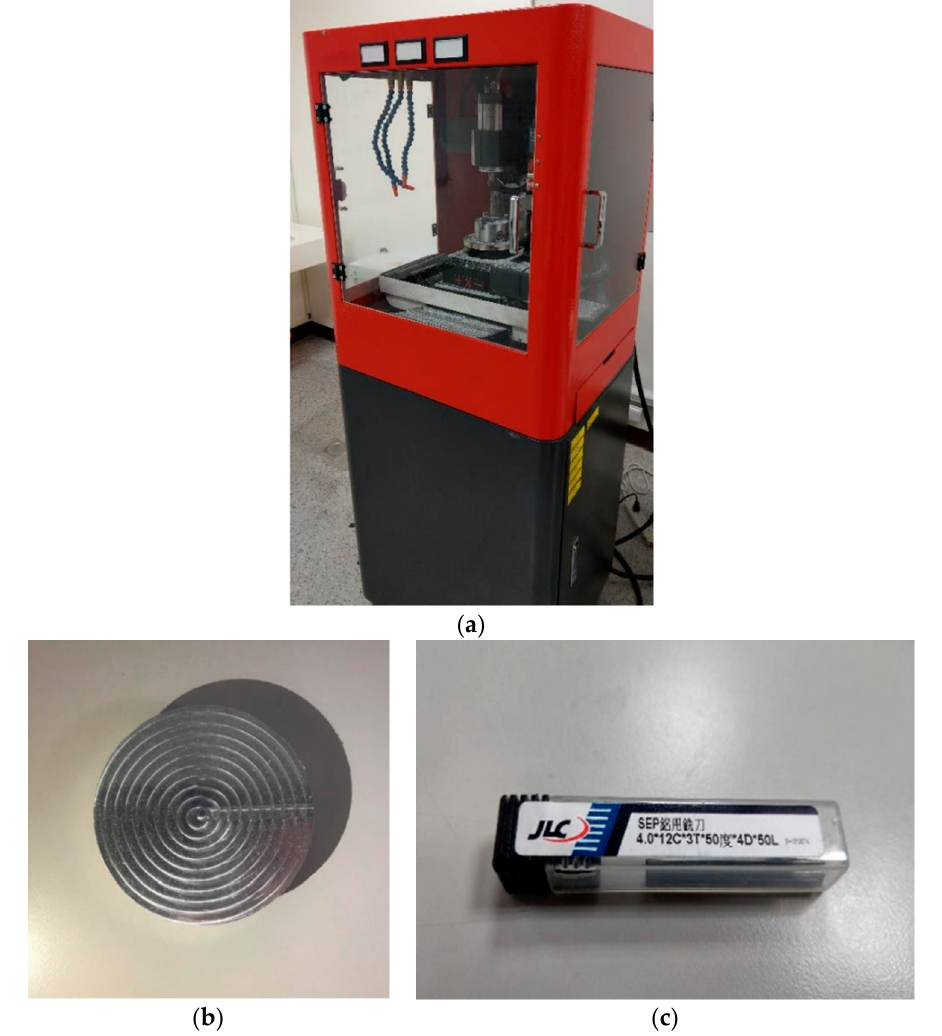
Figure 3. Machine tools and equipment. ( a ) Mini 5-Axis-CNC small five-axis machine tool; ( b ) aluminum for cutting; ( c ) milling cutter for cutting. Table 1. Cutting